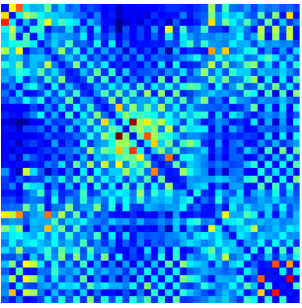
Fig. 3 Estimated coefficient matrix ˆ W in the dummy head